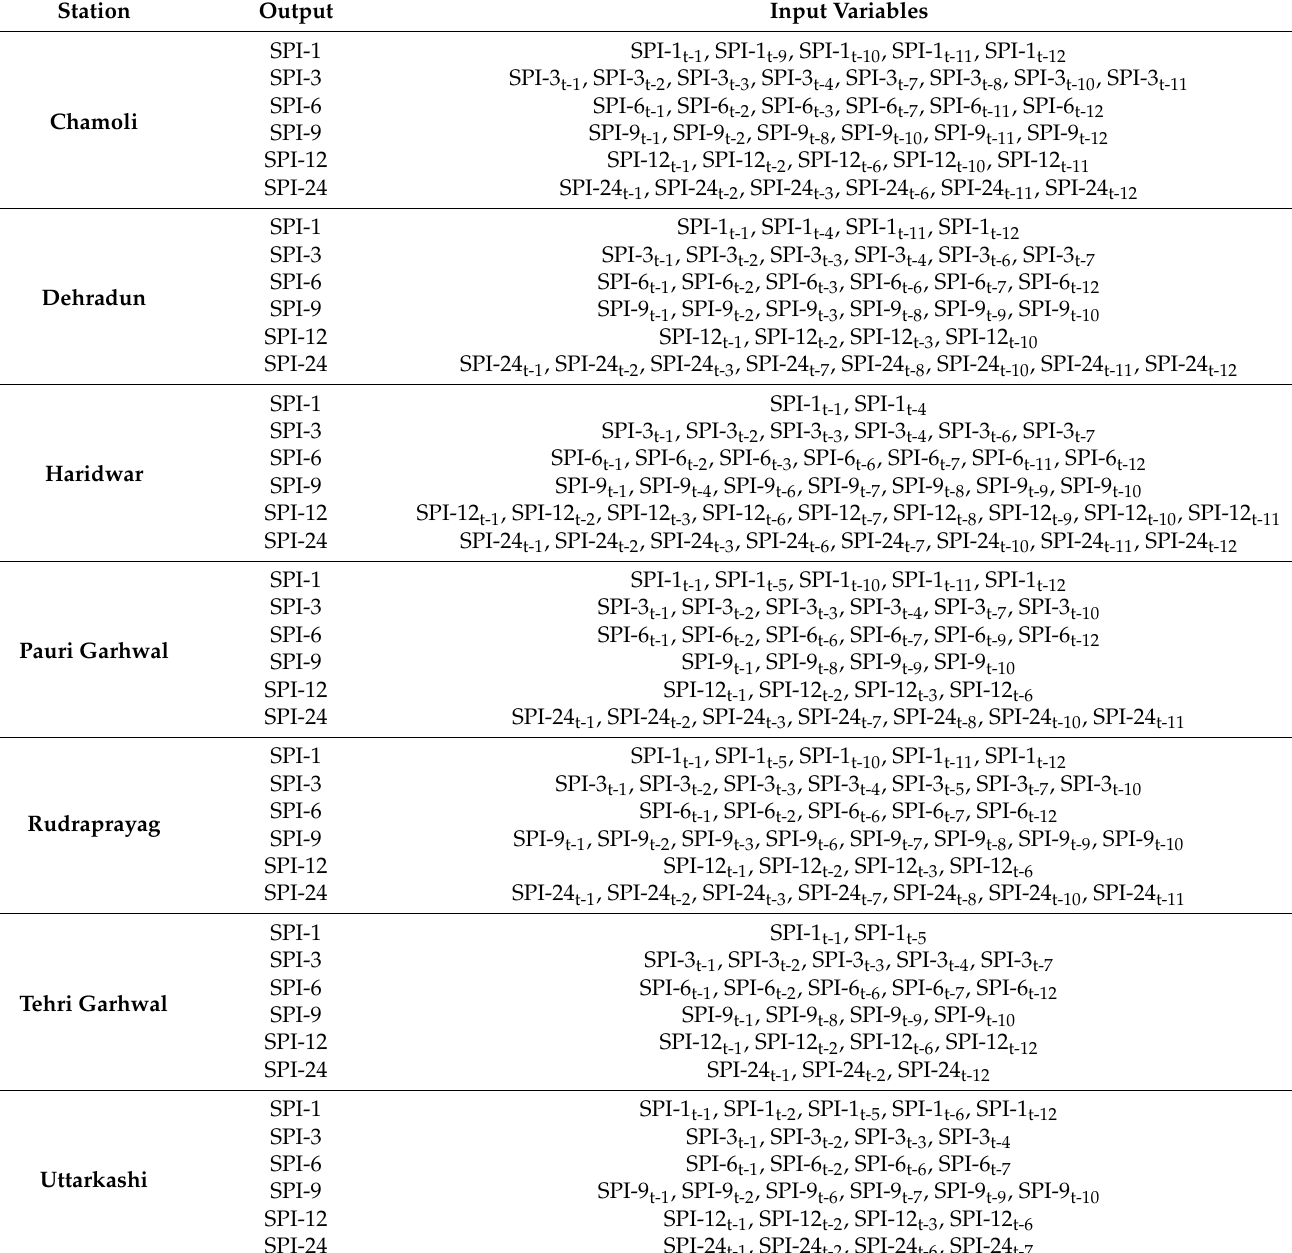
Table 3. Output–input relationship for multi-scalar SPI prediction using AI and regression models at study stations.